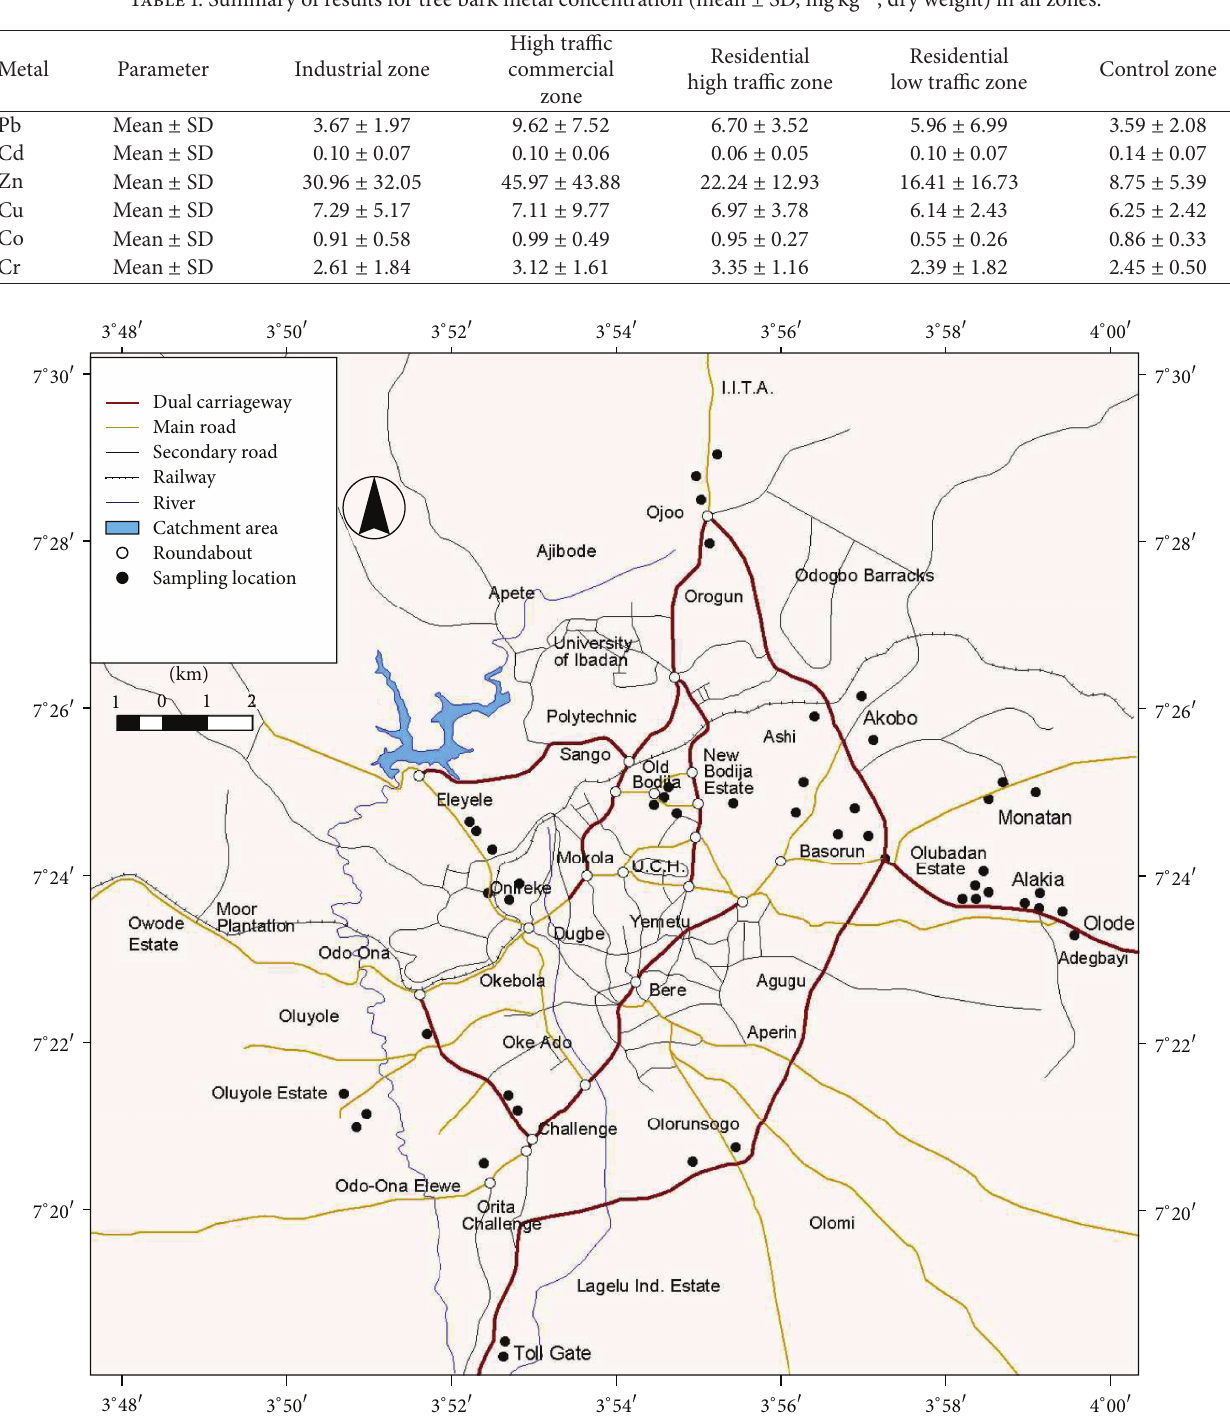
Figure 1: Ibadan City map showing the various sampling